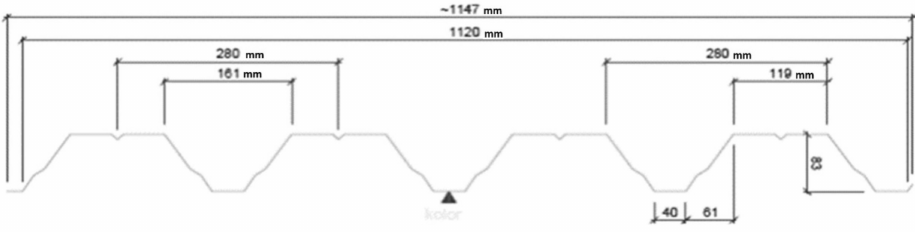
Figure 25. Geometrical features of the T85 × 0.75 profile used in the tests and computer simulations.